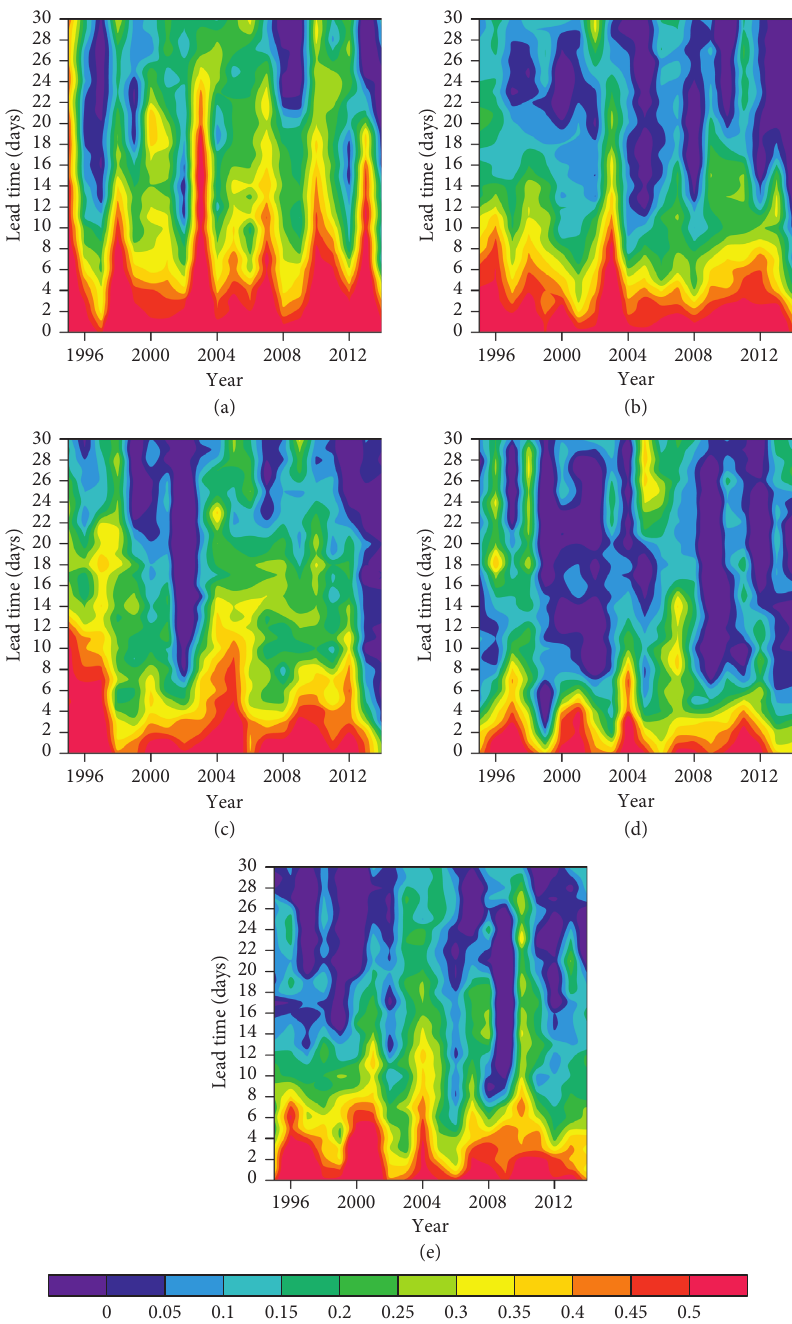
Figure 3: Interannual variation (1995–2014) of the TCC between the ensemble mean and observed summer accumulated ten-day pre- cipitation for ECMWF S2S hindcast experiment at the lead times of 0–30 days in five subregions (a-e) of eastern China. (a) Reg1, (b)